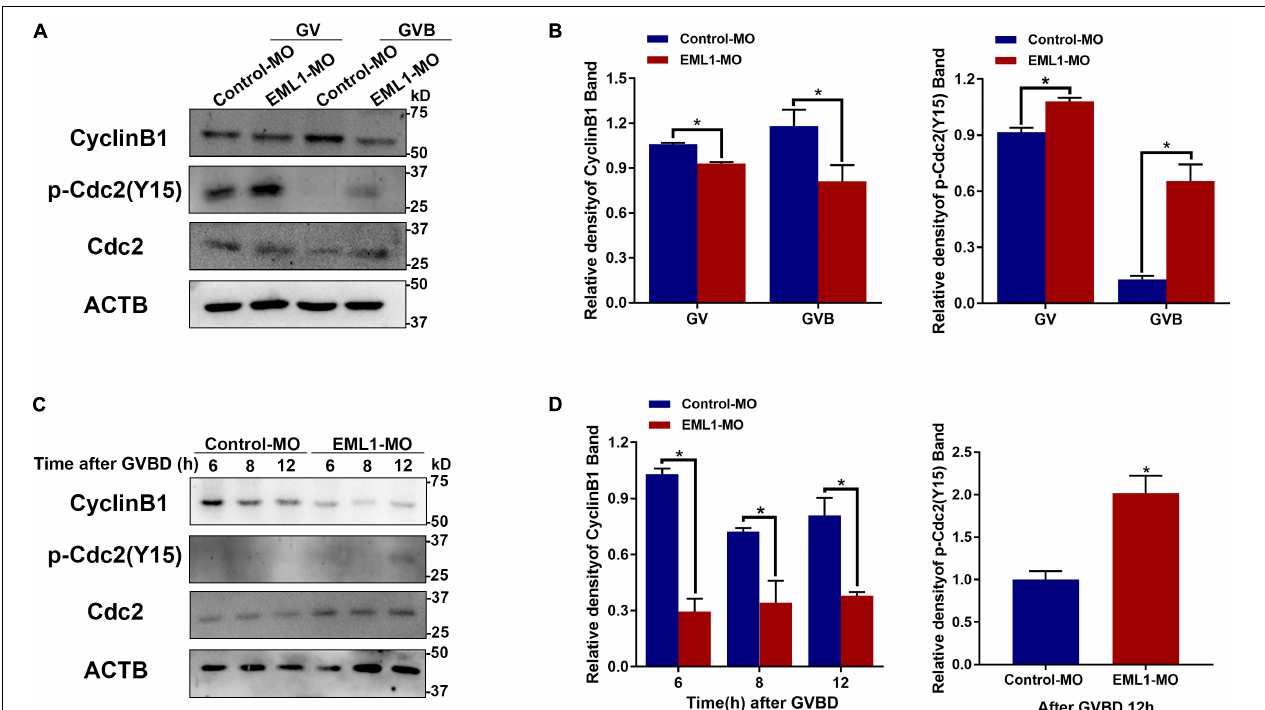
FIGURE 8 | Depletion of EML1 in oocytes impairs the activation of MPF. Dynamic changes in the levels of CCNB1, pCDK1-Y15, and CDK1 in the oocytes during the period of oocytes meiosis resumption (A,B) and MI-to-MII transition (C,D) were assessed by Western Blot analysis, with the level of ACTB used as internal control. Lysate from 50 oocytes was loaded in each lane. The representative gel images of three independent experiments are shown in panels (A,C) , and the quantification of the Western Blot results are shown in panels (B,D) . * P < 0.05, compared with the Control-MO